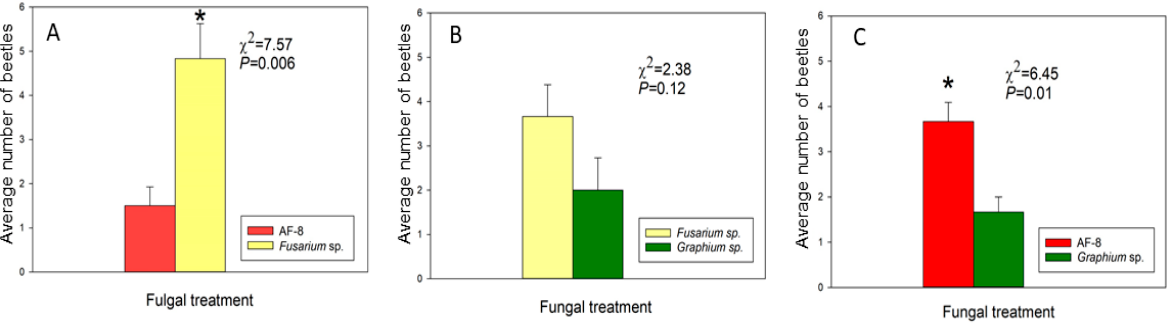
Figure 6. Avocado sawdust disks inoculated with symbiotic fungi and offered to E. perbrevis in dual-choice assays. Mean number of E. perbrevis in, on or next to the disk after 12 h. ( A ) AF-8 vs. Fusarium sp. nov., ( B ) Fusarium sp. nov. vs. Graphium sp., ( C ) AF-8 vs. Graphium sp. * Indicates significant difference in attraction between the two choices ( p < 0.05).